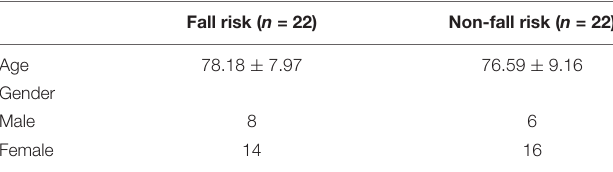
TABLE 1 | Demographic data of subjects at-risk of falling and not at-risk.